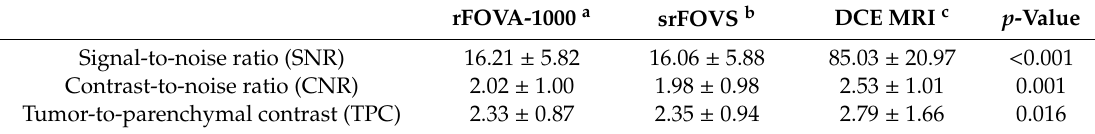
Table 4. Comparisons of quantitative parameters among rFOVA-1000, srFOVS, and DCE